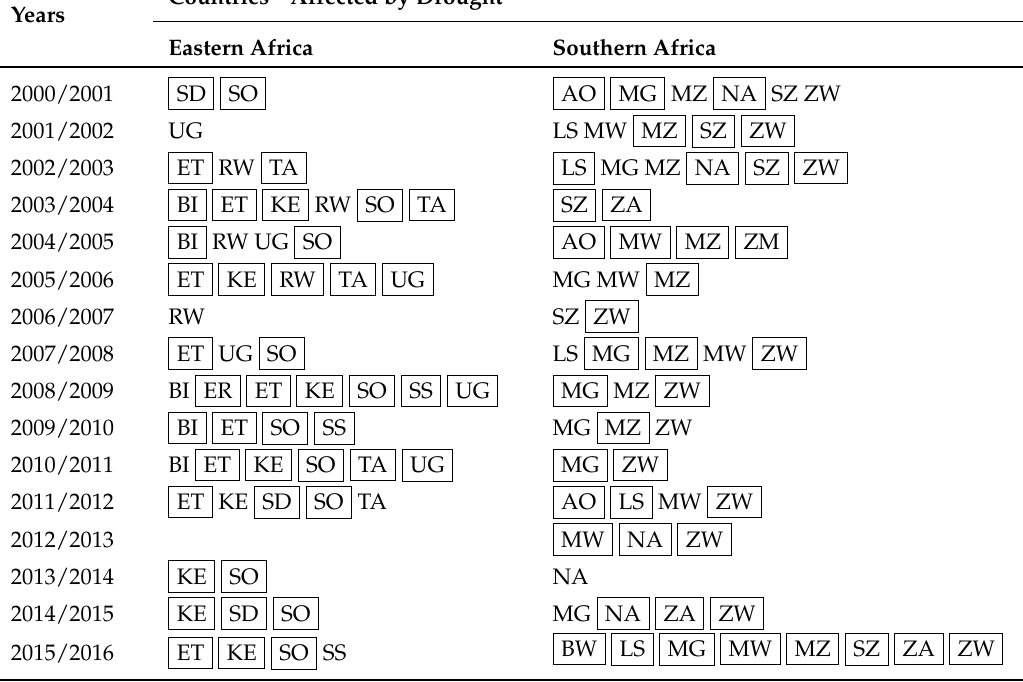
* Country codes: AO = Angola, BI = Burundi, BW = Botswana, ER = Eritrea, ET = Ethiopia, KE = Kenya, LS = Lesotho, MG = Madagascar, MZ = Mozambique, MW = Malawi, NA = Namibia, RW = Rwanda, SD = Sudan, SO = Somalia, SS = South Sudan, SZ = Swaziland, TA = Tanzania, UG = Uganda, ZA = South Africa, ZM = Zambia, ZW =